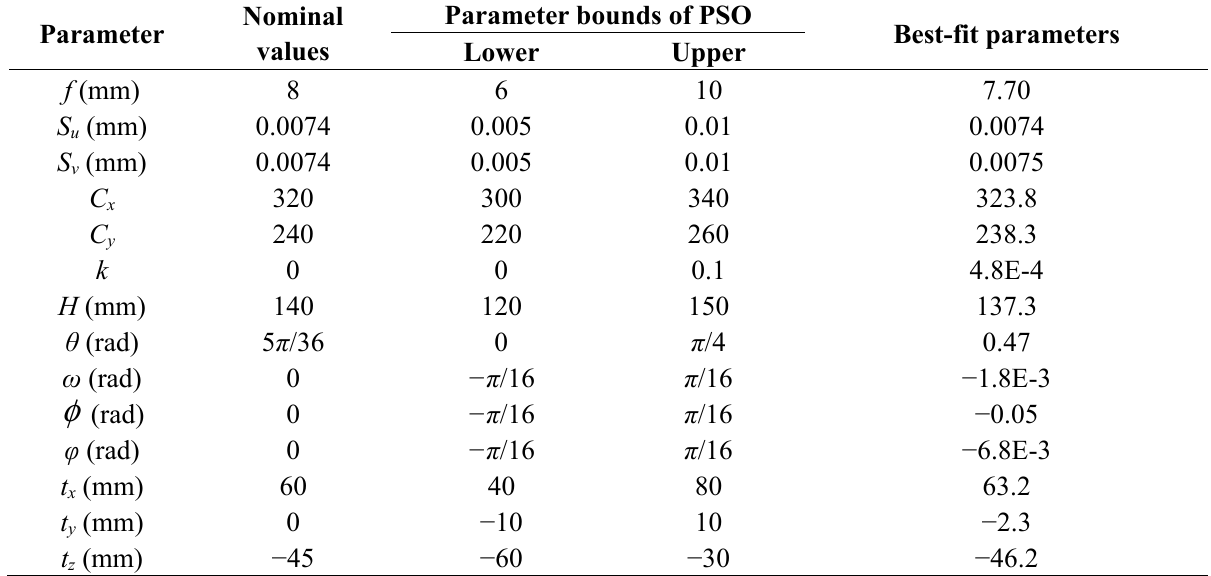
Table 2. Parameter identification results.